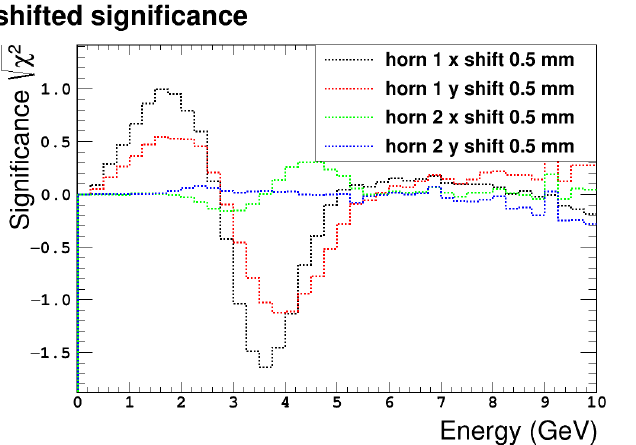
Figure 134. The significance of the spectral shift in the reconstructed neutrino energy on-axis for neutrino interactions in the fiducial volume of the 3DST for different horn